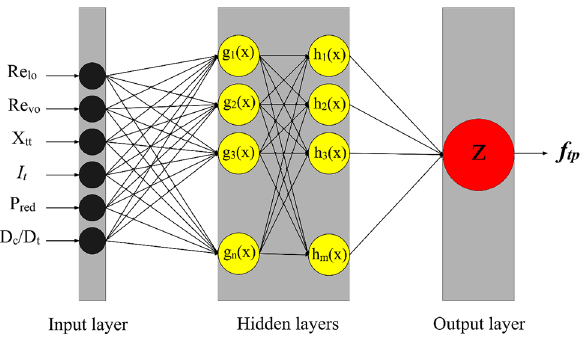
Figure 1. MLP network for used estimation of two-phase FPD in coiled